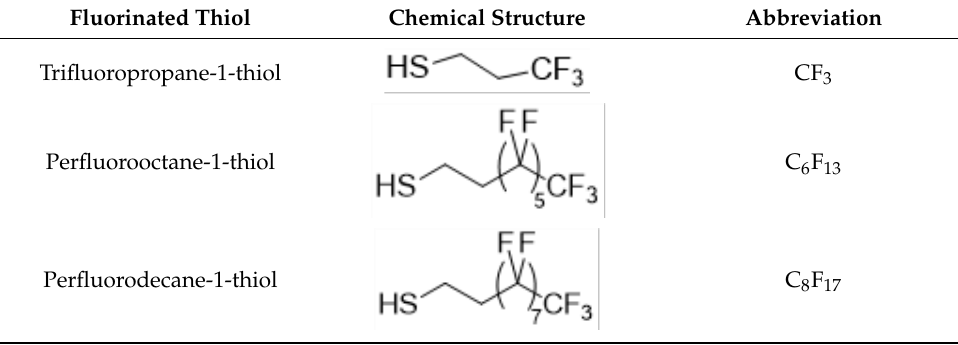
Figure 2. The synthetic route for the production of PFOB loaded nanocapsules. Table 1. Chemical structures of the different perfluorinated thiols.